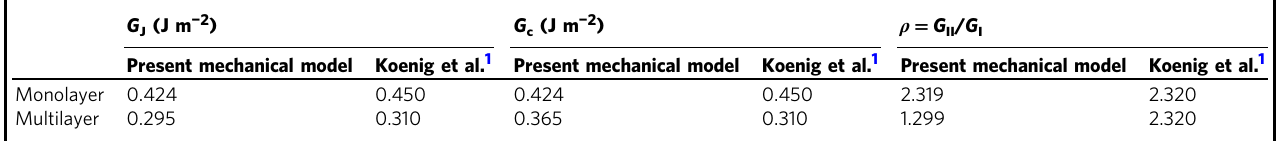
Table 1 Average adhesion toughness of multilayer graphene fi